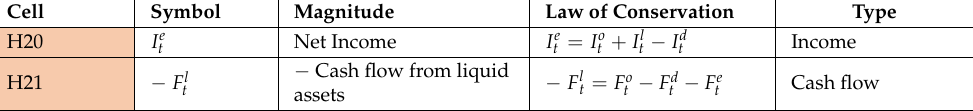
Table 8. Cells whose values are calculated with the law of conservation (pink orange cells). Cell Symbol Magnitude Law of Conservation Type H20 I e t Net Income